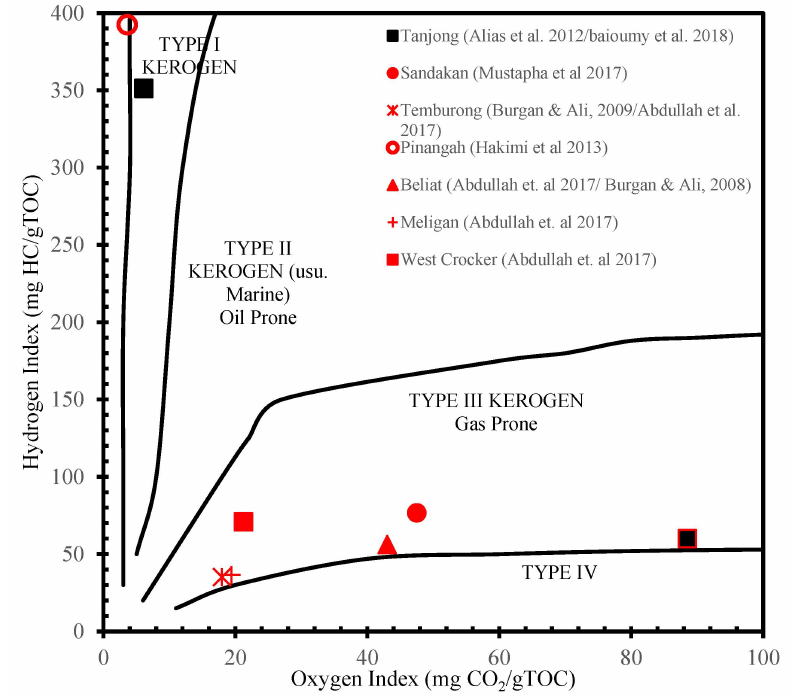
Figure 10. OI versus HI plot showing the type of kerogen for formations in Sabah.